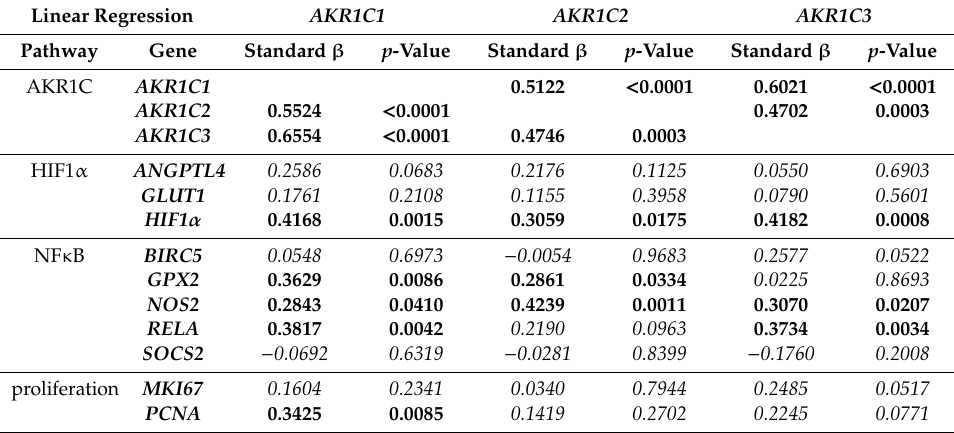
Table 1. The gene expression levels of AKR1C1 , AKR1C2, and AKR1C3 were related to the genes indicated using multiple linear regression models, which were adjusted for age and BMI in benign prostate and PCa samples of PCa patients, both with and without type 2 diabetes ( n = 56). Standard β values represent standardized regression coefficients. Significant gene associations are indicated in bold lettering, nonsignificant gene associations in italics. Statistical significance was considered as p < 0.05.